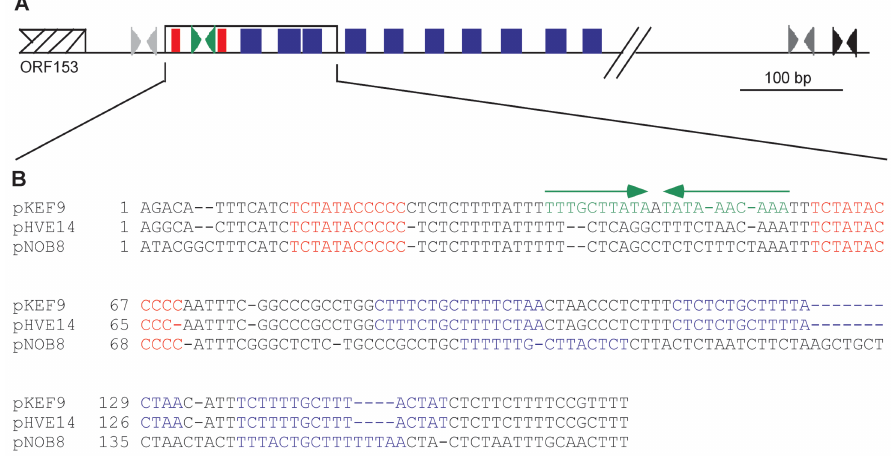
Figure 3. (A) Putative replica- tion origin. Red boxes = 10–11 bp perfect direct repeats; blue boxes = 16 bp imperfect di- rect repeats; dark grey arrows = inverted repeats conserved in all plasmids; green arrows = in- verted repeats conserved in pKEF9, pING1, pARN3 and pARN4; and light grey arrows = inverted repeats conserved in pHVE14 and pNOB8. Black ar- rows = plasmid-specific inverted repeats. (B) The 170 bp con- served region. The 10–11 bp re- peats are shown in red and 16 bp imperfect repeats are shown in blue. The total number of these imperfect repeats is: pKEF9 = 13, pHVE14 = 10; pNOB8 = 6; pING1 = 12; pARN3 = 9; and pARN4 = 8. Inverted repeats are shown in